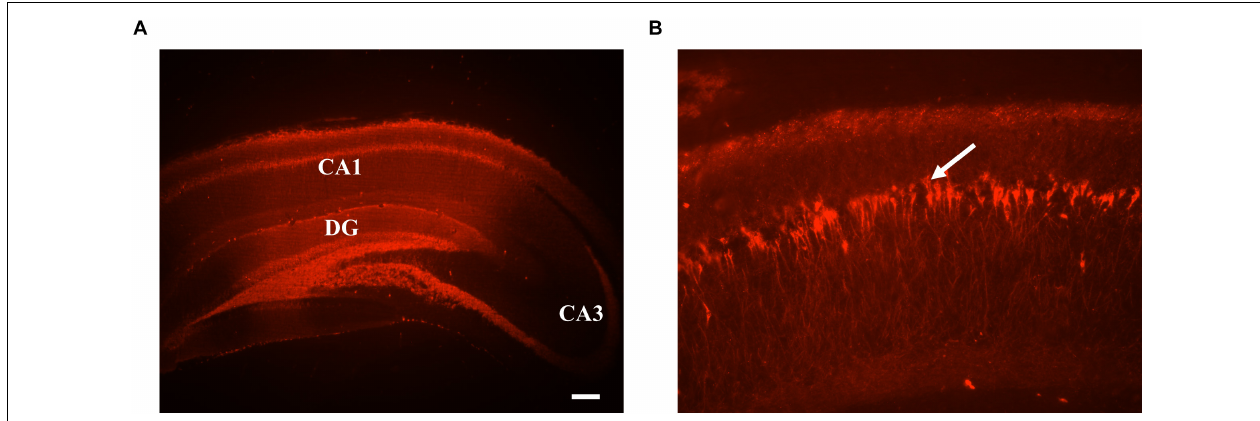
FIGURE 6 | (A) Representative histological images of coronal sections of rat brain hippocampus expressing GtACR2-mCherry at the site of recording. GtACR2 expressing neurons appear in red color. The scale bar measures 200 µ m. (B) Magnified view of a small area of CA1, GtACR2-mCherry neurons designated by the